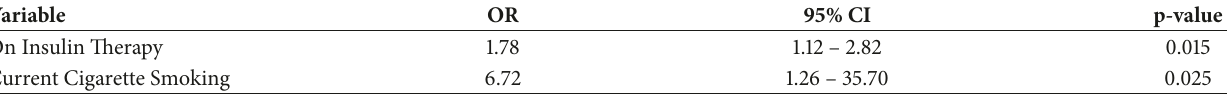
Table 3: Multivariate analysis for predictors of mild to moderate depression among diabetic patients.